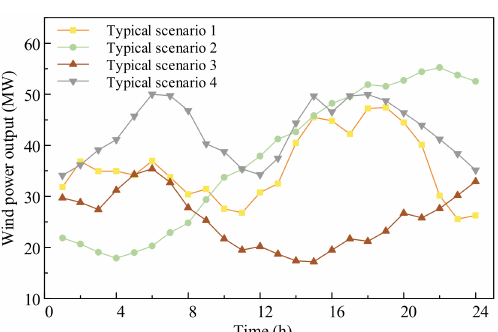
Figure A1. Day-ahead wind power output curve.